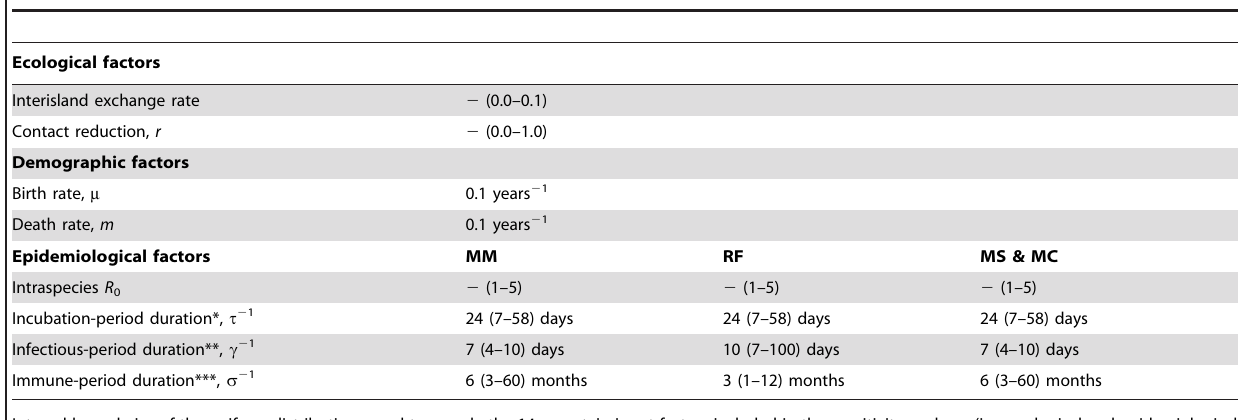
Table 2. Parameter values.